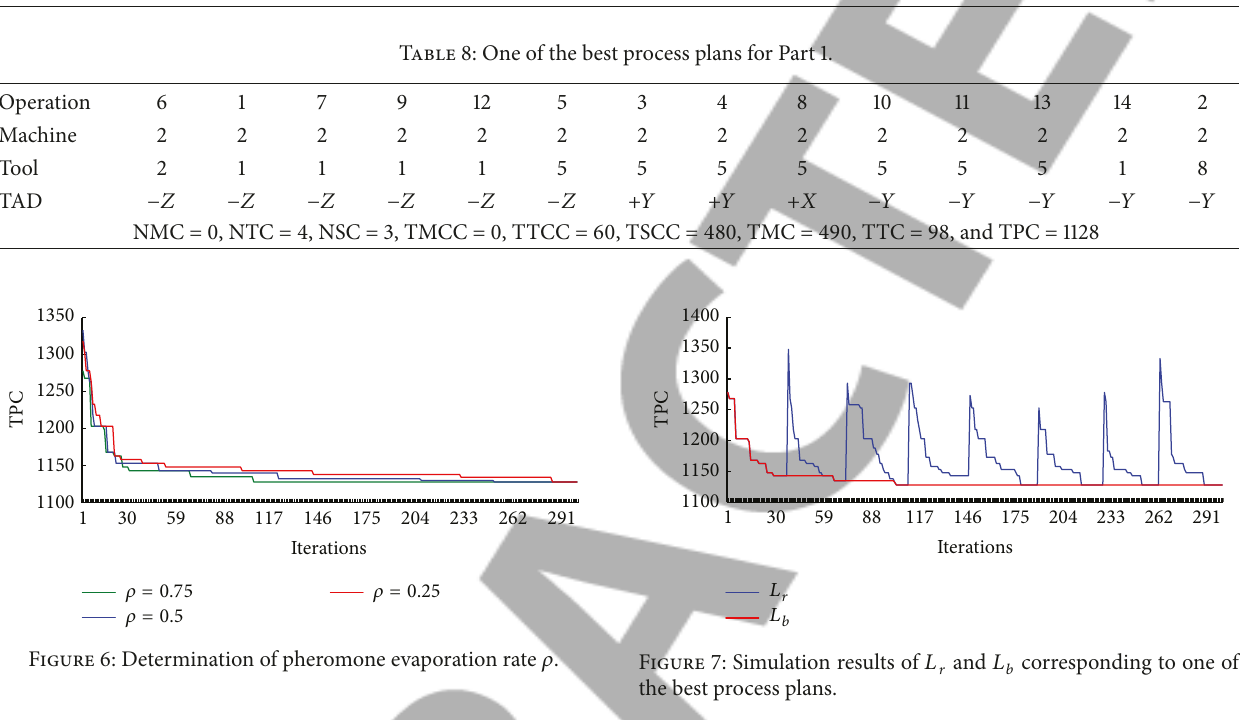
Figure 6: Determination of pheromone evaporation rate 𝜌 . Figure 7: Simulation results of 𝐿 𝑟 and 𝐿 𝑏 corresponding to one of the best process